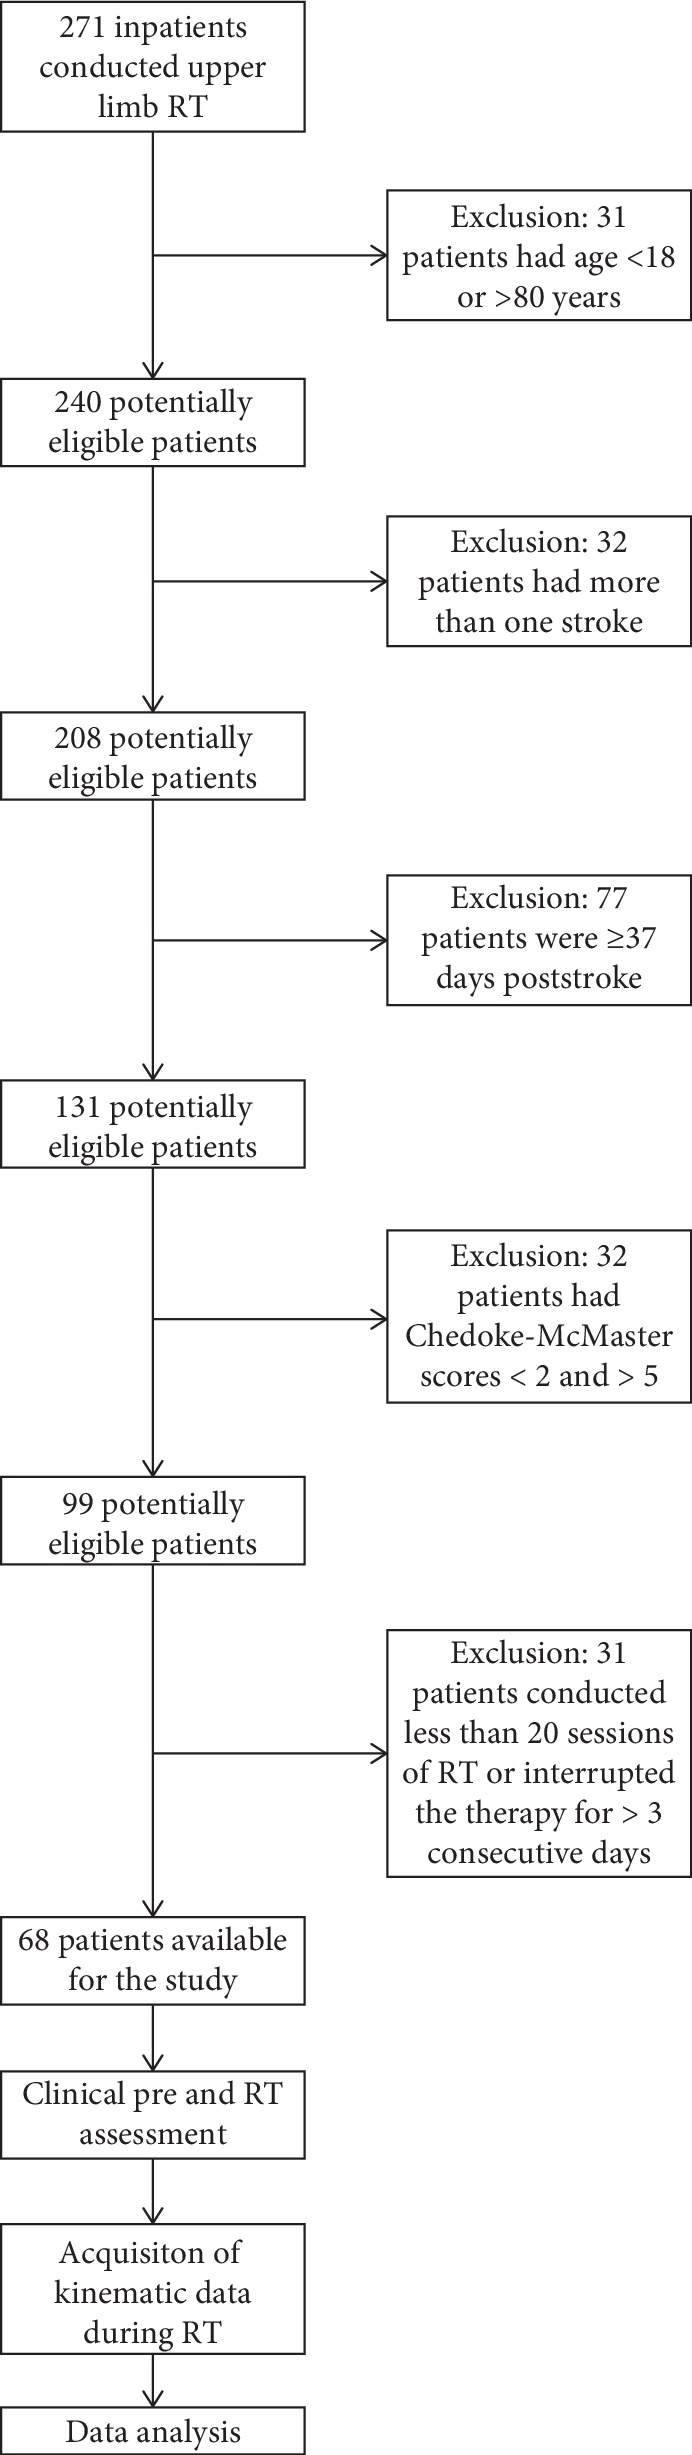
Consort diagram.